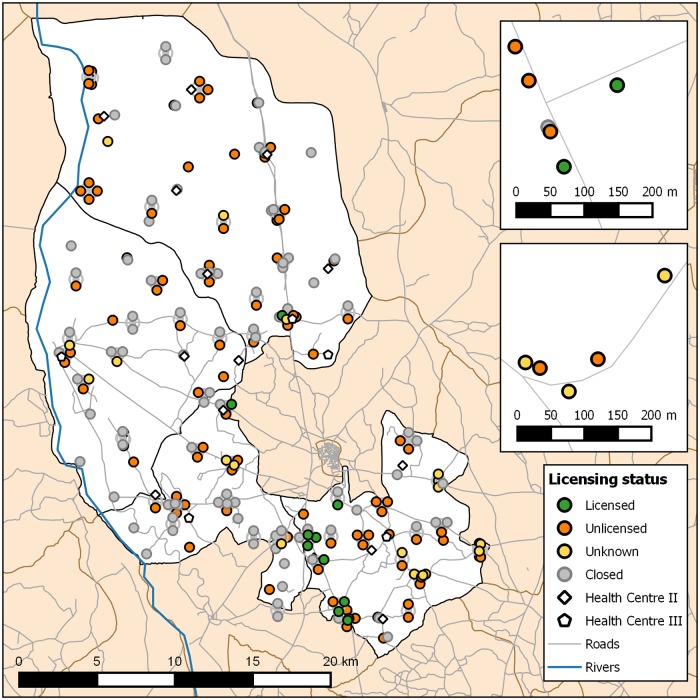
Licensing status of open drug shops and availability of health facilities in four sub-counties.Symbols of drug shops in very close proximity are displaced in an orbit around the actual location. Insets: representative close-ups illustrating the high degree of spatial clustering of drug shops. Data courtesy of OpenStreetMap (openstreetmap.org; OpenStreetMap contributors).